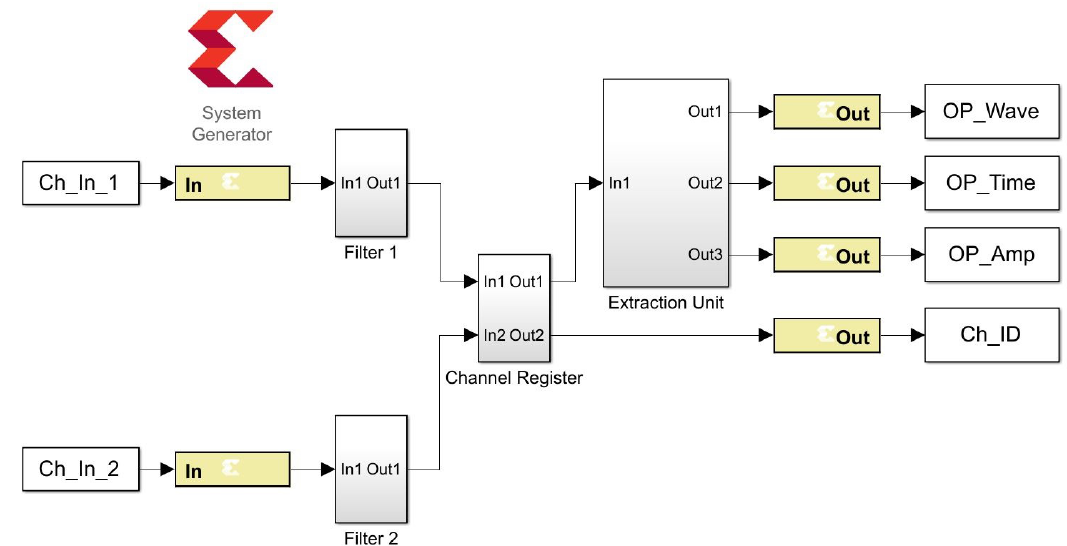
Figure 8. Design of a multichannel unfiltered input system (MCUF) in SysGen.